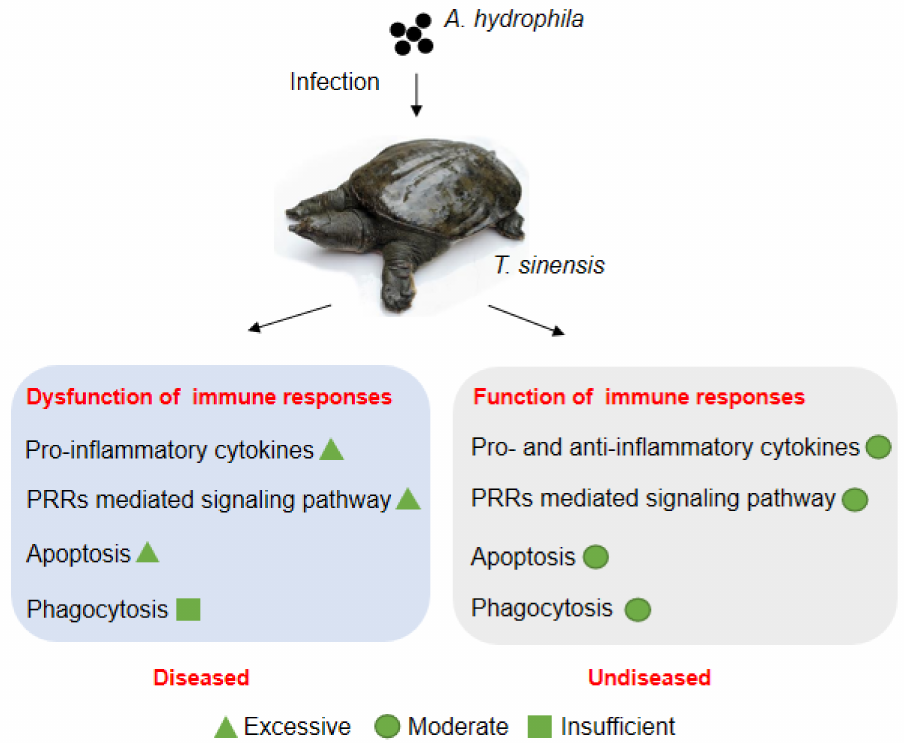
Figure 8. The suspected molecular immunopathogenesis of hemorrhagic sepsis caused by A. hy- drophila infection in Chinese soft-shelled